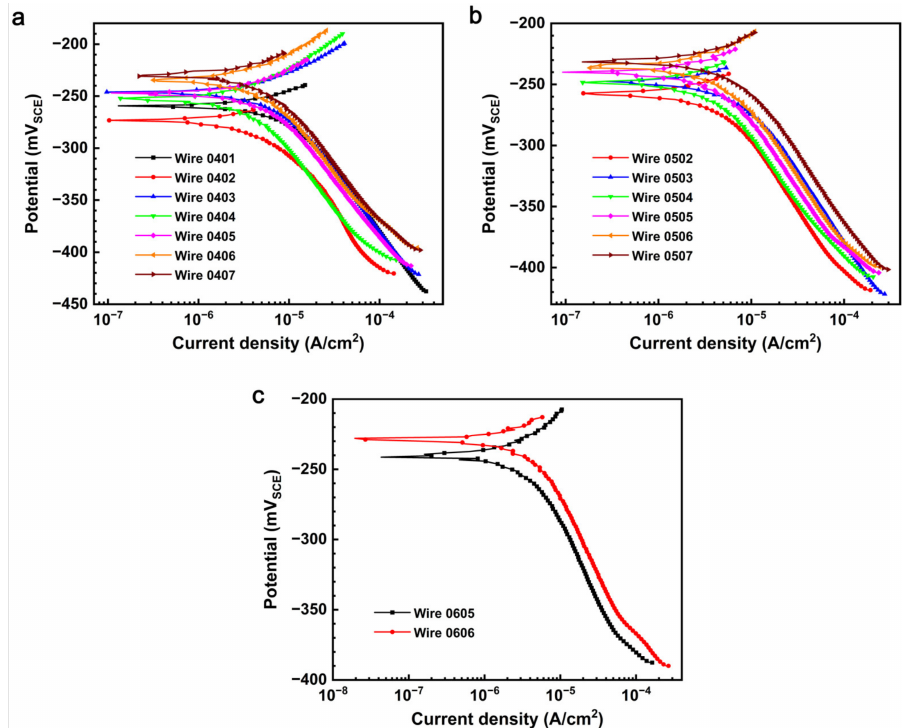
Figure 8. Potentiodynamic polarization curves of the ( a ) 4th, ( b ) 5th and ( c ) 6th column of 90/10 copper–nickel alloy WBE after 168 h impingement at 5 m/s using 1 wt.% NaCl solution with 0.2 wt.% sand